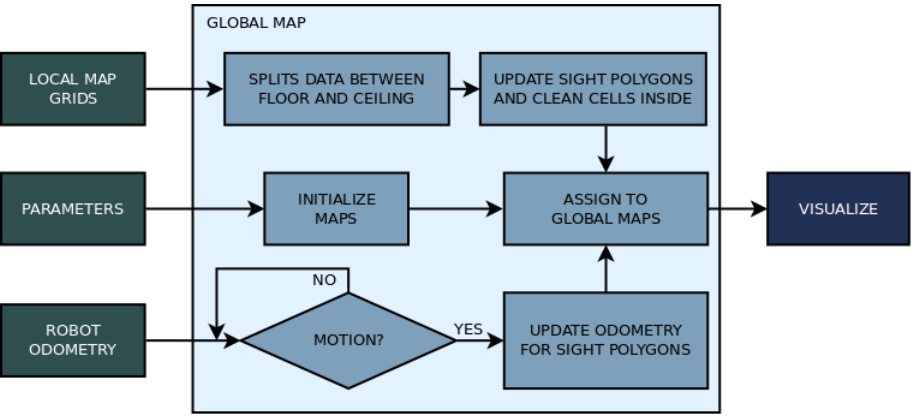
Figure 9. Flow chart of the algorithm that builds the global map.